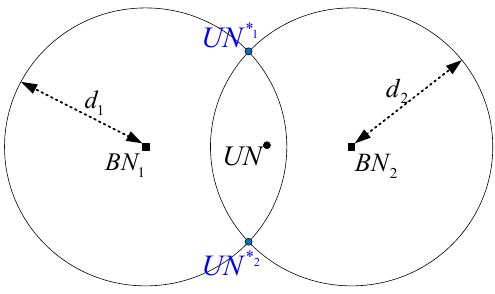
Figure 3. Constraint principle in ideal conditions.